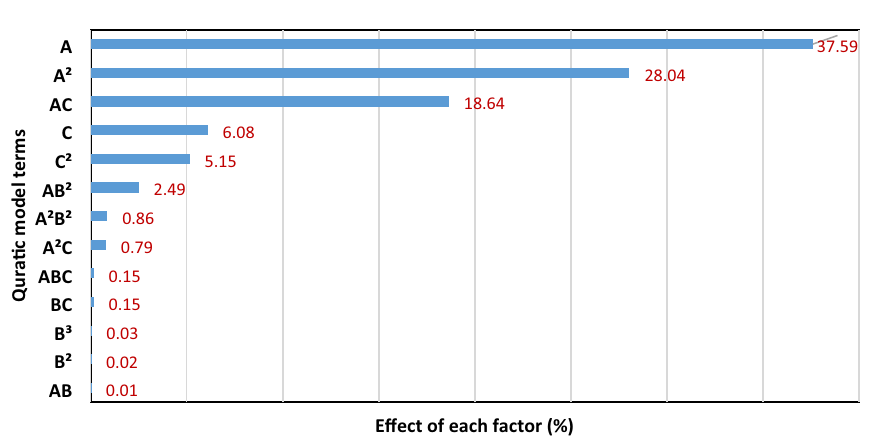
Figure 3. Graph of Pareto analysis representing the contribution of model terms on Cr(VI) reduction (%) response.